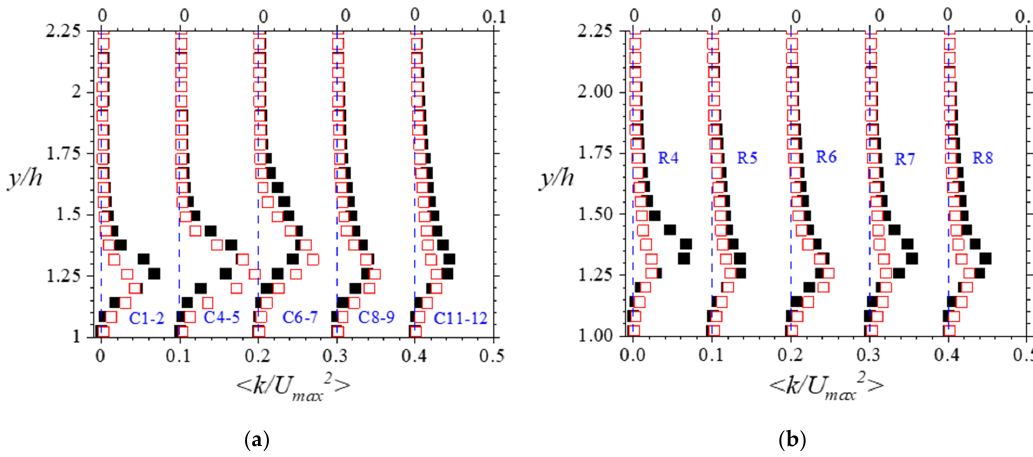
Figure 18. Turbulent kinetic energy profiles for the flow in the open region are shown. The plots are shown as normalized by the local maximum line-averaged streamwise mean velocity in both open and porous regions. Staggered plots ( a ) show the streamwise variations whereas staggered plots ( b ) demonstrate the spanwise variations. The denominations C and R respectively stand for columns and rows, and are illustrated in Figure 1. Black-filled boxes are the results for Test A , and red-open boxes are the results for Test B